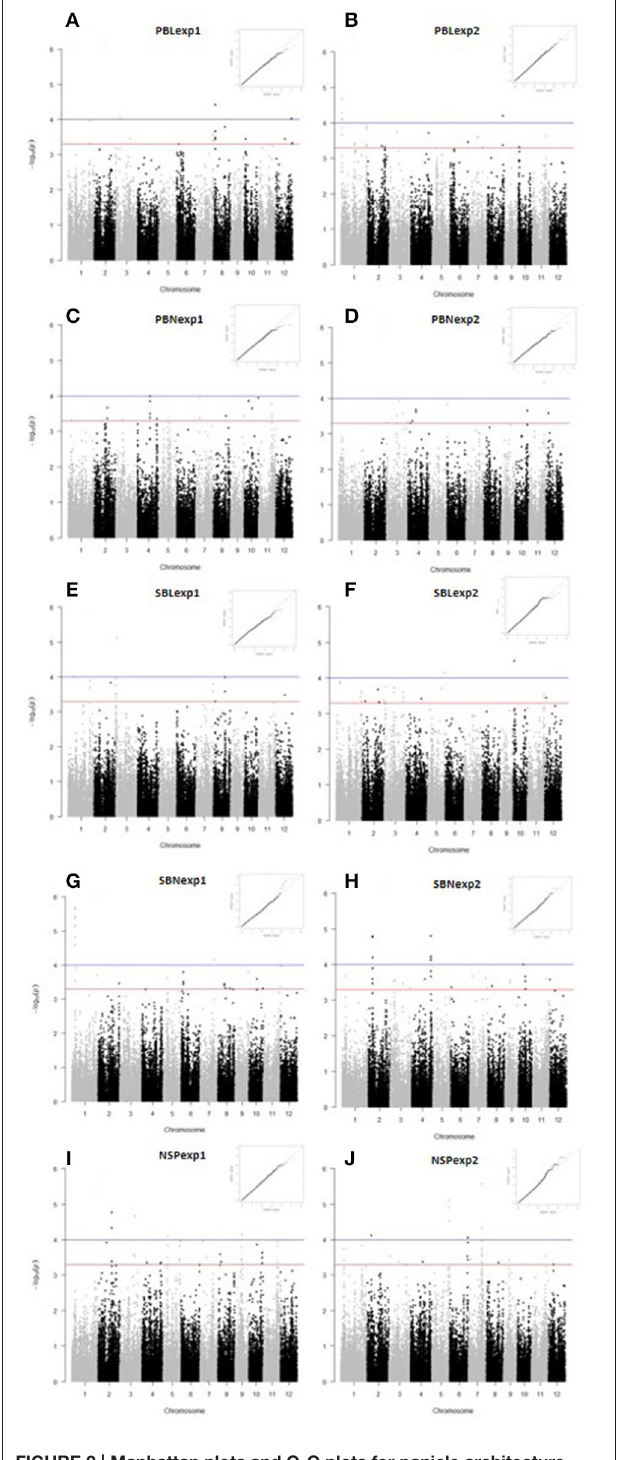
FIGURE 2 | Manhattan plots and Q-Q plots for panicle architecture related traits and number of spikelets per panicle. (A) PBLexp1, (B) PBLexp2, (C) PBNexp1, (D) PBNexp2, (E) SBLexp1, (F) SBLexp2, (G) SBNexp1, (H) SBNexp2, (I) NSPexp1, and (J) NSPexp2. In the Manhattan plots the blue line and red lines indicates the threshold for significant SNP association at p < 1 × 10 − 4 and p < 5 × 10 − 4